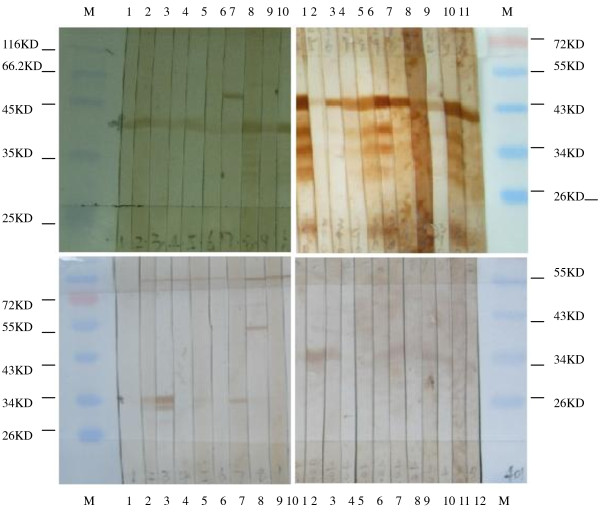
Part of the results of the detection of IgG against s108 (EV71) VP1 (A), s67 (EV71) VP4 (B), s390 (CA16) VP1 (C) and s401 (CA16) VP4 (D) by Western Blot. Western blot assay using goat anti-human IgG as secondary antibody. Lanes 1-10 in A, lanes 1-10 in B, lanes 1-11 in C and Lanes 1-12 in D represent immunoblotting with sera from adult for regular health check up. M represents molecular weight Marker (Fermentas, #SM0671).